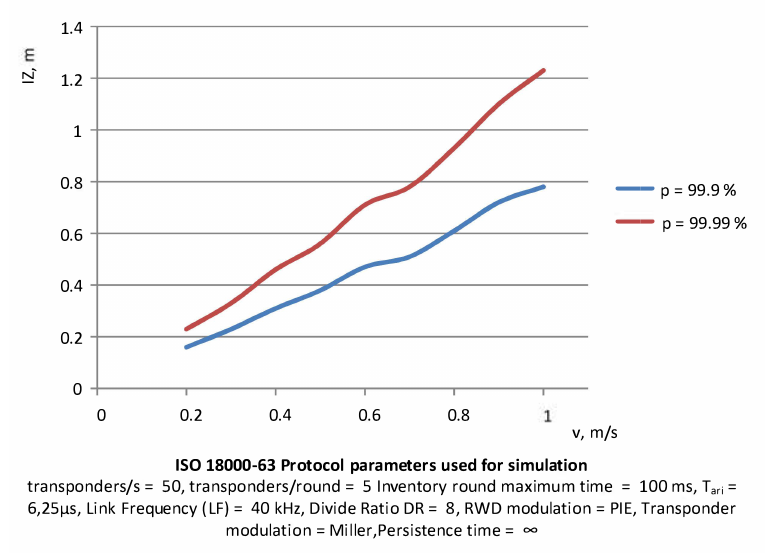
Figure 17. Determination of the interrogation zone in dependence on the speed of the group of transponders at assumed probability